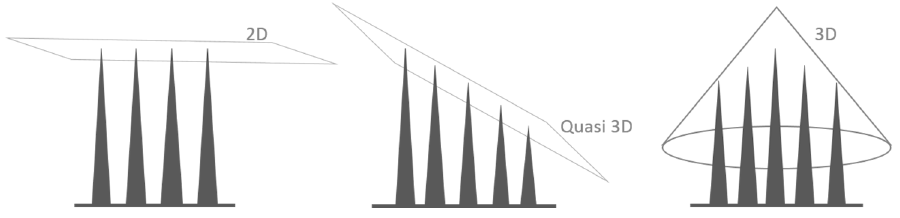
Figure 1. Schematic of the 2D, quasi 3D, and 3D MEAs.